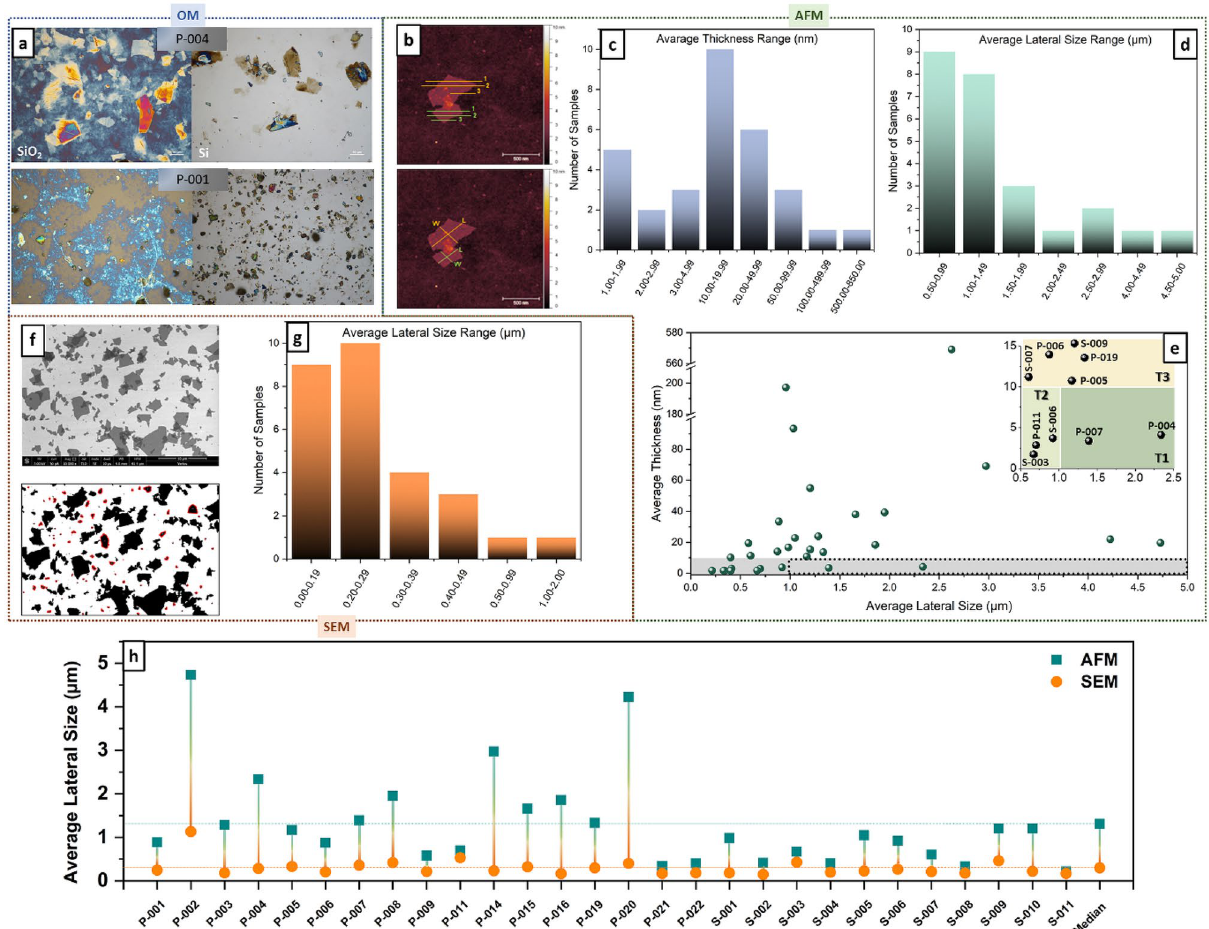
Figure 1. Thickness and lateral size determination. ( a ) Examples of OM images of samples characterized using Si/SiO 2 or Si substrates. ( b ) Examples of thickness and lateral size collection by AFM, followed by the distributions of average ( c ) thickness and ( d ) lateral size, and ( e ) correlation between thickness and lateral size for each sample with the inset representing 3 different Tiers (T1 = h ≤ 10 nm and l ≥ 1 μm; T2 = h ≤ 10 nm and 1 μm > l ≥ 0.5 μm; T3 = 15 nm ≥ h > 10 nm and l ≥ 0.5 μm). ( f ) Example of SEM image for lateral size collection, highlighting the smaller often neglected flake fragments, followed by ( g ) the lateral size distribution using a software interface. ( h ) Finally, the difference between the average lateral size obtained from AFM (manually) and SEM